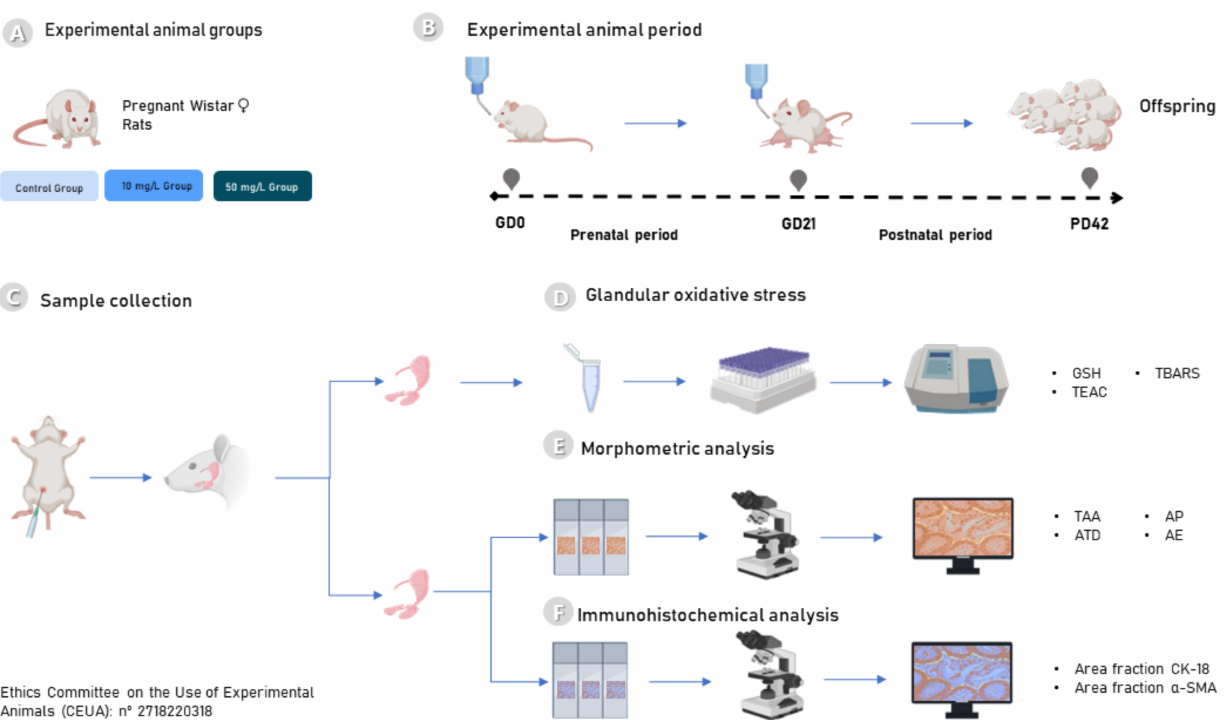
Figure 6. Overview of the experimental protocol. In ( A ), division of the rats into the experimental groups; in ( B ), developmental stages of the rats and their offspring before sample collection; in ( C ), collection of PA and SM glands; in ( D ), evaluation of glandular oxidative stress; in ( E ), morphometric analysis of the salivary glands and in ( F ), immunohistochemical analysis of the